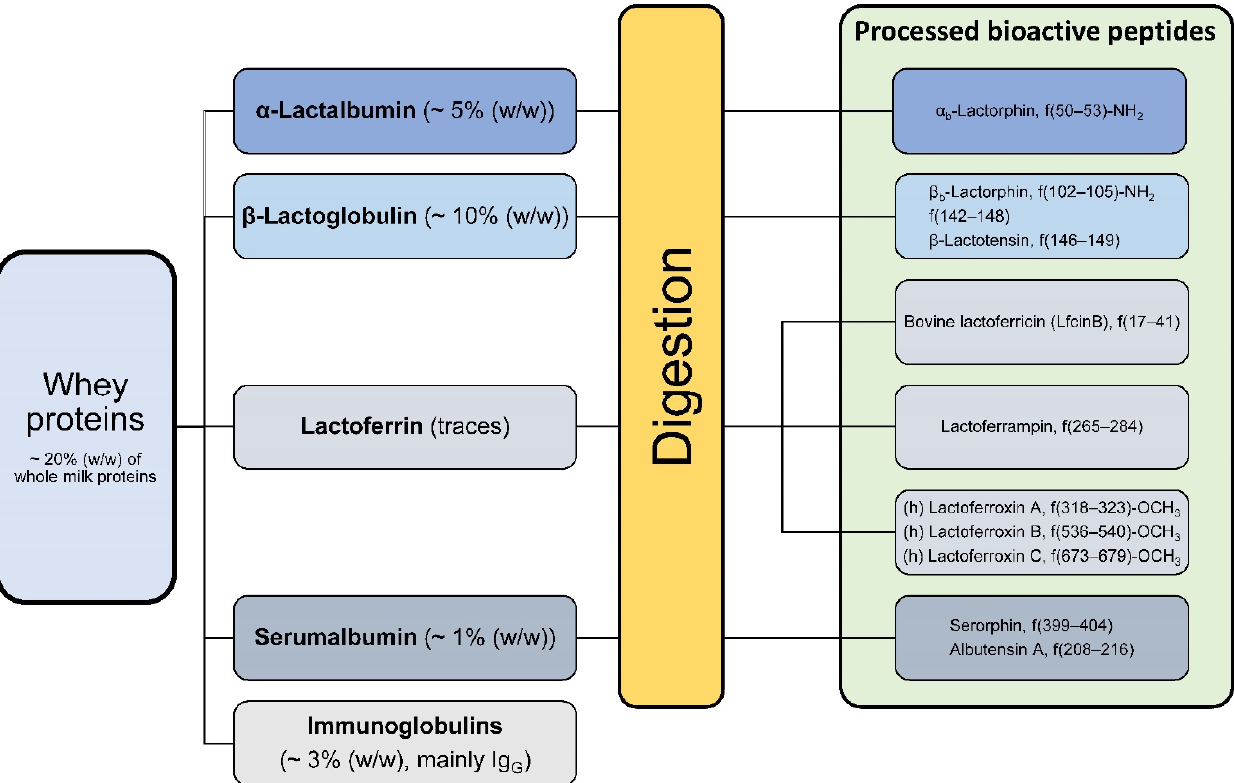
Figure 3. Overview of the soluble whey proteins and their share in the total protein fraction. The green box indicates some processed peptide variants after whey protein digestion. Some of them are α -amides, methyl esters or have free α -carboxyl groups [20,23].